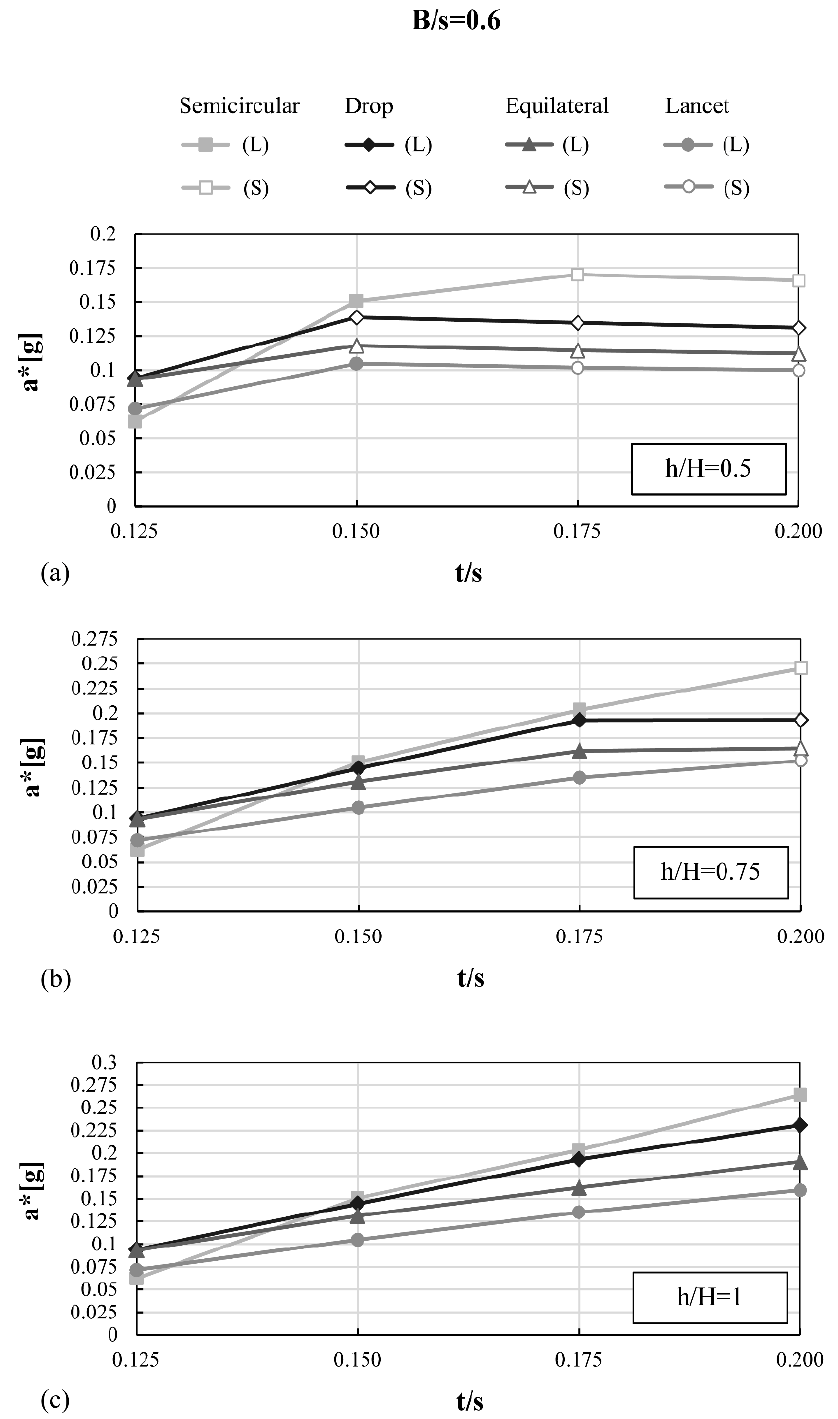
Figure 14. Values of a* for each considered eccentricity, each h/H configuration and B/s = 0.6, expressed with respect to the t/s ratio: ( a ) h/H = 0.5, ( b ) h/H = 0.75 and ( c ) h/H = 1.0. Local mechanism (L) or semi-global mechanism (S) are highlighted.